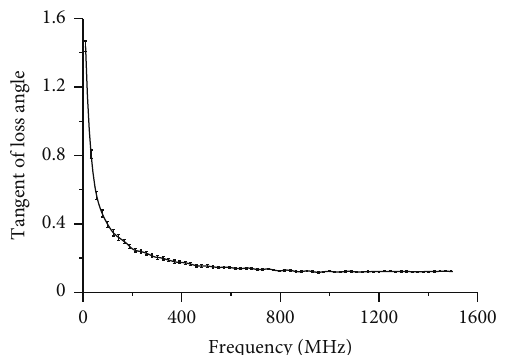
Figure 8: The sample #5 tangent of loss angular error statistical characteristic under di ff erent frequency.